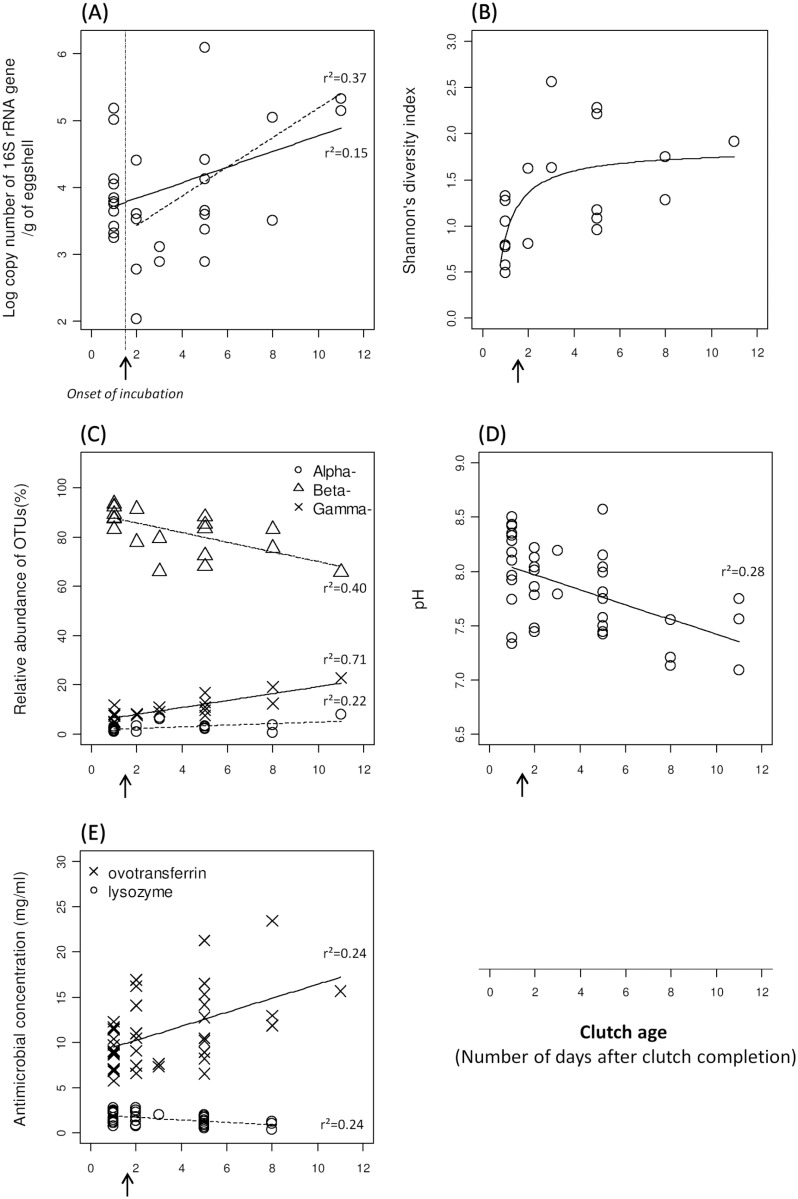
Egg-related bacteria and antimicrobials associated with clutch age.The clutch age is the number of days that the completed clutch spent in the nest; day 1 is the day of clutch completion. Incubation starts between day 1 and day 2 (arrow). ‘r2’ corresponds to the coefficient of determination between clutch age and bacterial/antimicrobial data. (A) Bacterial abundance is examined from day 1 to day 11 (full line) and from day 2 to day 11 (dashed line). (B) Shannon‘s diversity index. (C) Relative abundance of Operational Taxonomic Units (OTUs) of three main classes of Proteobacteria: Alphaproteobacteria (Alpha-) (dotted line), Betaproteobacteria (Beta-) (dashed line) and Gammaproteobacteria (Gamma-) (full line). (D) Albumen pH. (E) Lysozyme (dashed line) and ovotransferrin (full line) concentrations.